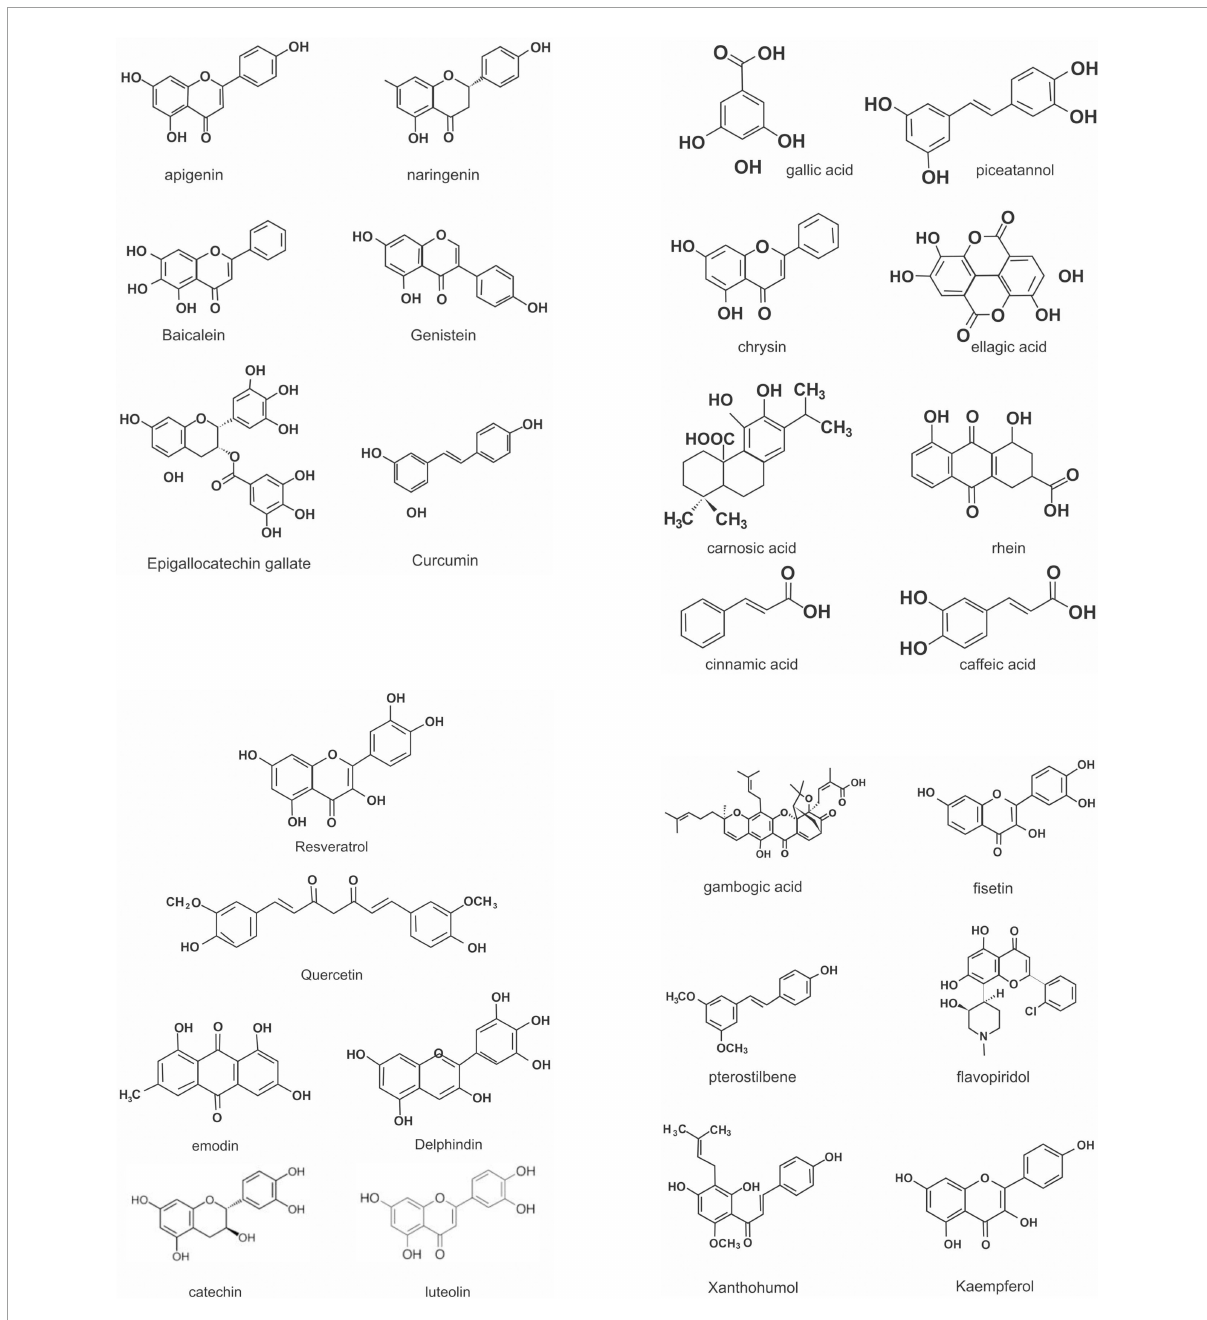
FIGURE2 Chemical structures of some polyphenols.